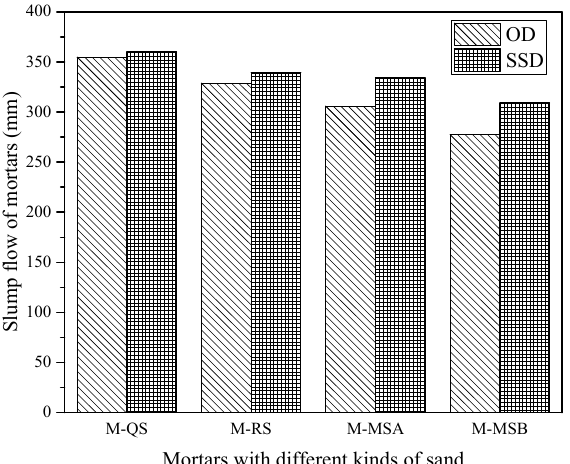
Figure 5. Slump flows of mortars with four kinds of sands.